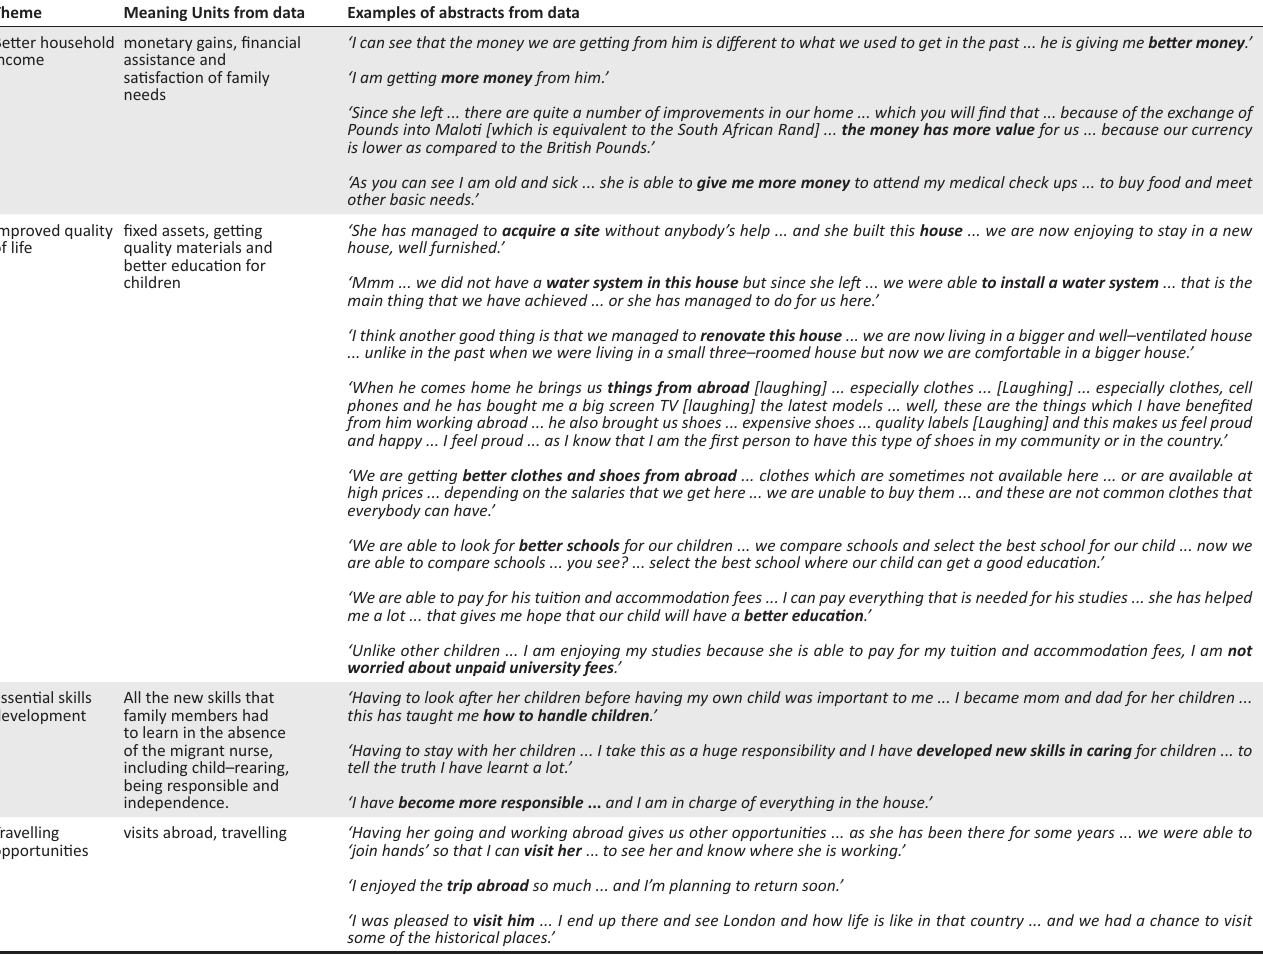
TABLE 2: The meanings related to the benefits of nurse